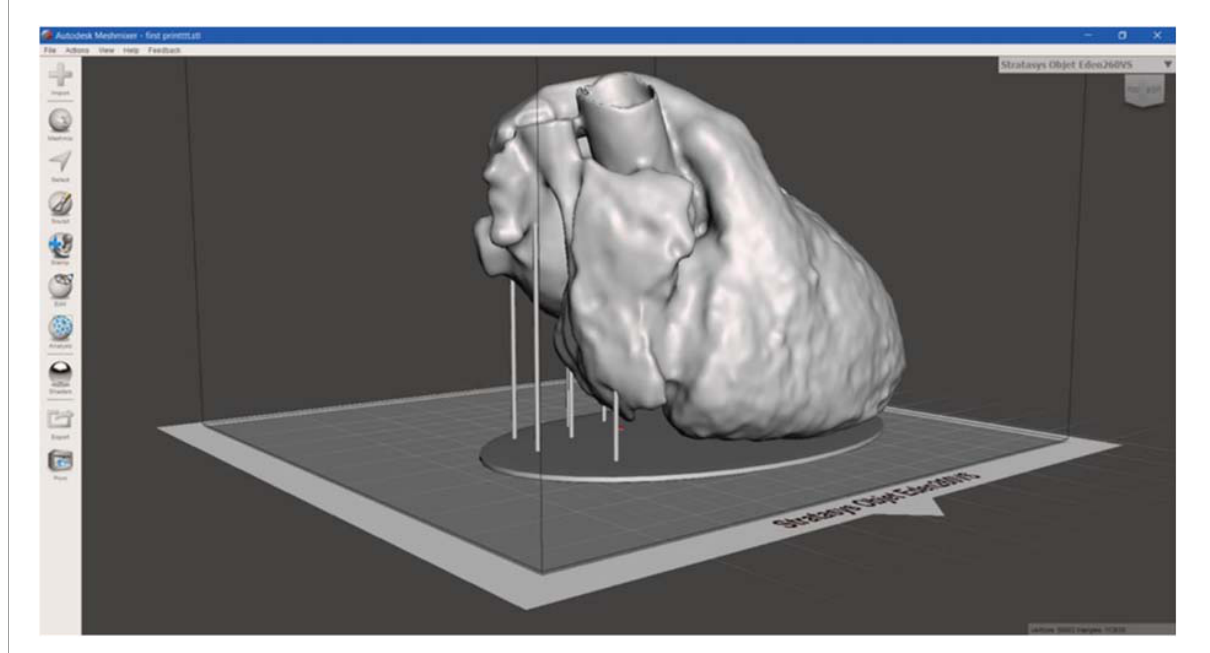
FIGURE7 3D heart phantom model. 3D model of heart phantom with additional components, such as the base and the vertical cylindrical structures, which connects the base to the heart, to stabilize the model, useful to avoid the collapse during printing.